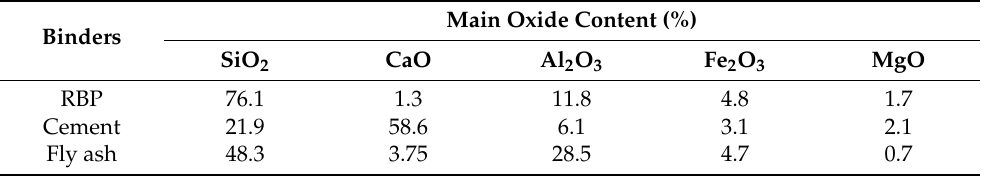
Table 2. Chemical composition of RBP, cement and fly